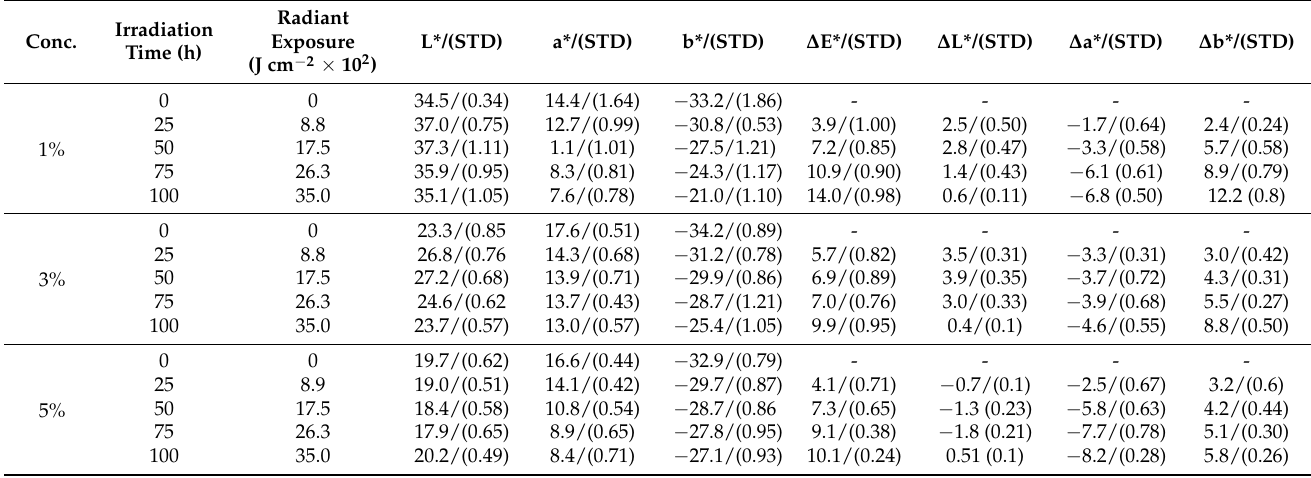
Table 2. Variation color parameters as a function of irradiation time and radiation dose for RB_204 dyed fabric. Conc.